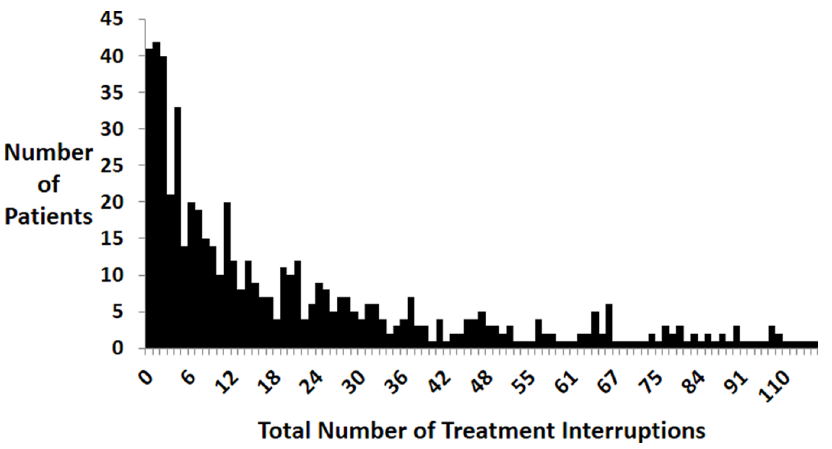
Figure 2. Distribution of number of total treatment interruptions among MDR TB patients, 1999–2006 (n=583).